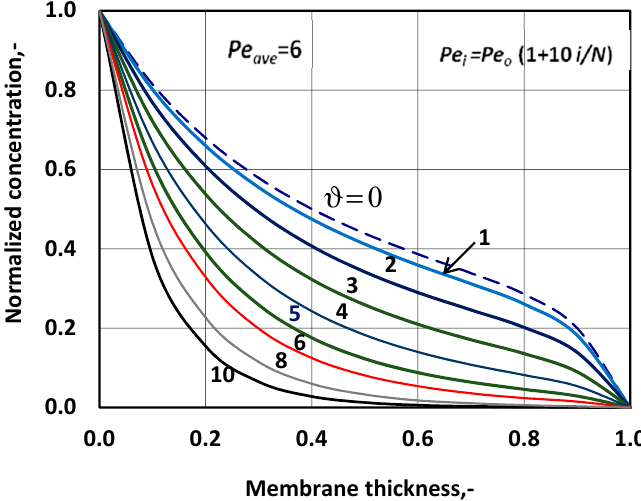
Figure 8. Concentration change with variable increasing Pe number as a function of the local coordinate at di ff erent values of the reaction rate constant; the solution of the algebraic equation system is published in [6] (pp. 280–282). ( D = constant; D = 1 × 10 − 9 m 2 / s; N = 400; Pe o = 1; φ Pe i = 1 −